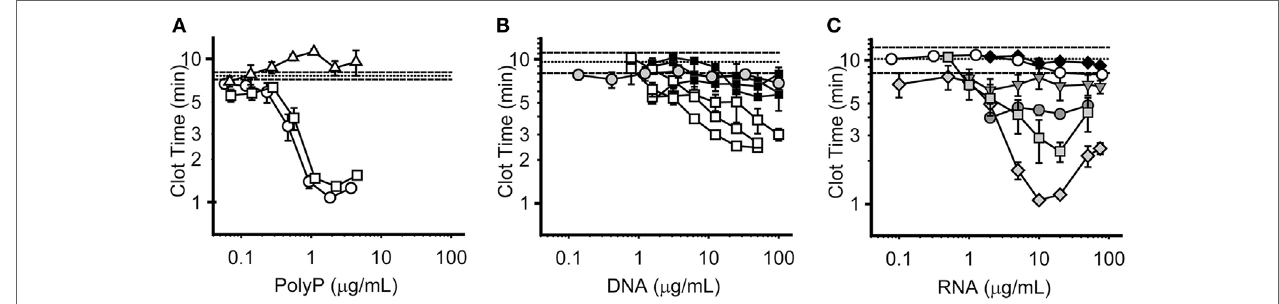
FigUre 4 | Procoagulant activities of polyphosphate (polyP), DNA, and RNA. Panels display plasma clot times versus concentration, with horizontal dashed lines showing the mean clot time without activator ( ± SEM as horizontal dotted lines). Symbols represent the mean, and error bars the SE, of three separate experiments evaluating clot times versus concentration. (a) Clot times with short-chain polyP (74 mer, Δ ); medium-chain polyP (385 mer, □ ); and long-chain polyP (1195 mer, ○ ). (B) Clot times with HEK 293 cell DNA isolated with phenol/chloroform ( □ , 3 distinct purifications); NET-derived DNA isolated with phenol/chloroform ( ■ , 3 distinct purifications); or lambda DNA ( ● ). Note that for comparison purposes, the clotting data for HEK 293 DNA and NET DNA in this panel are replotted from those in Supplemental Figure S2 in Supplementary Material of Smith et al. (26). (c) Clot times with HEK 293 cell RNA ( ◆ ); baker’s yeast transfer RNA ( ○ ); or the RNA homopolymers, polyA ( ▾ ), polyC ( ● ), polyI ( ■ ), or polyG ( ◆ ). PolyU was also tested, but had no procoagulant activity (data not